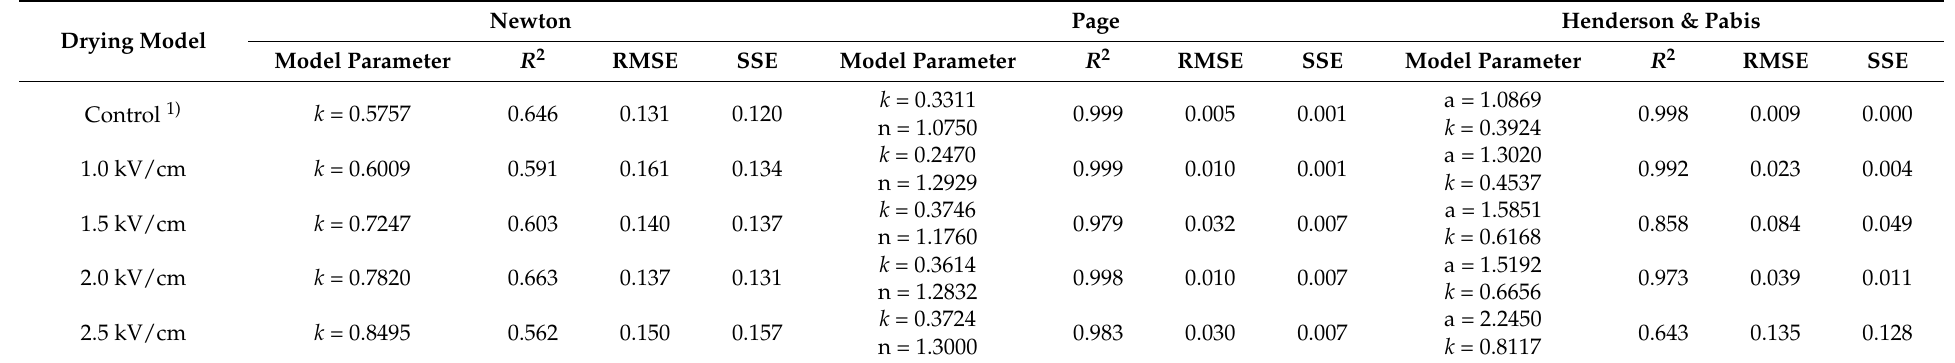
Table 1. Drying model coefficients for selected